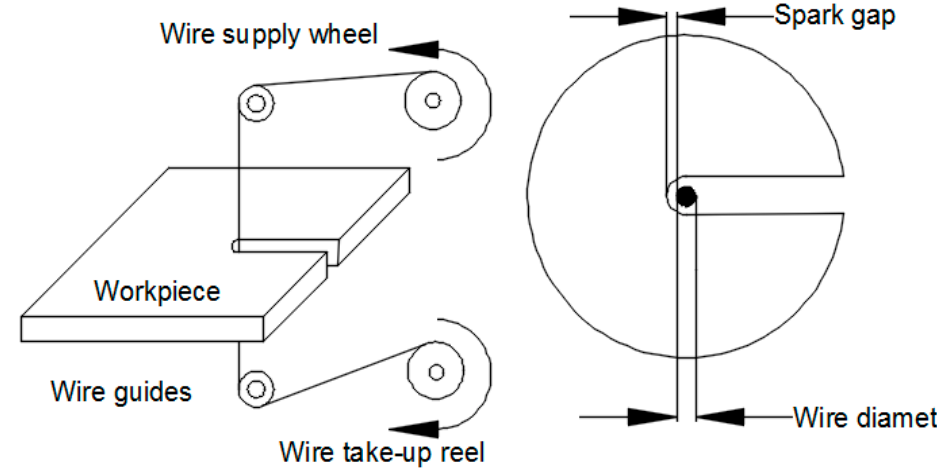
Figure 1. Schematic representation of the wire electrical discharge machining (WEDM) process.